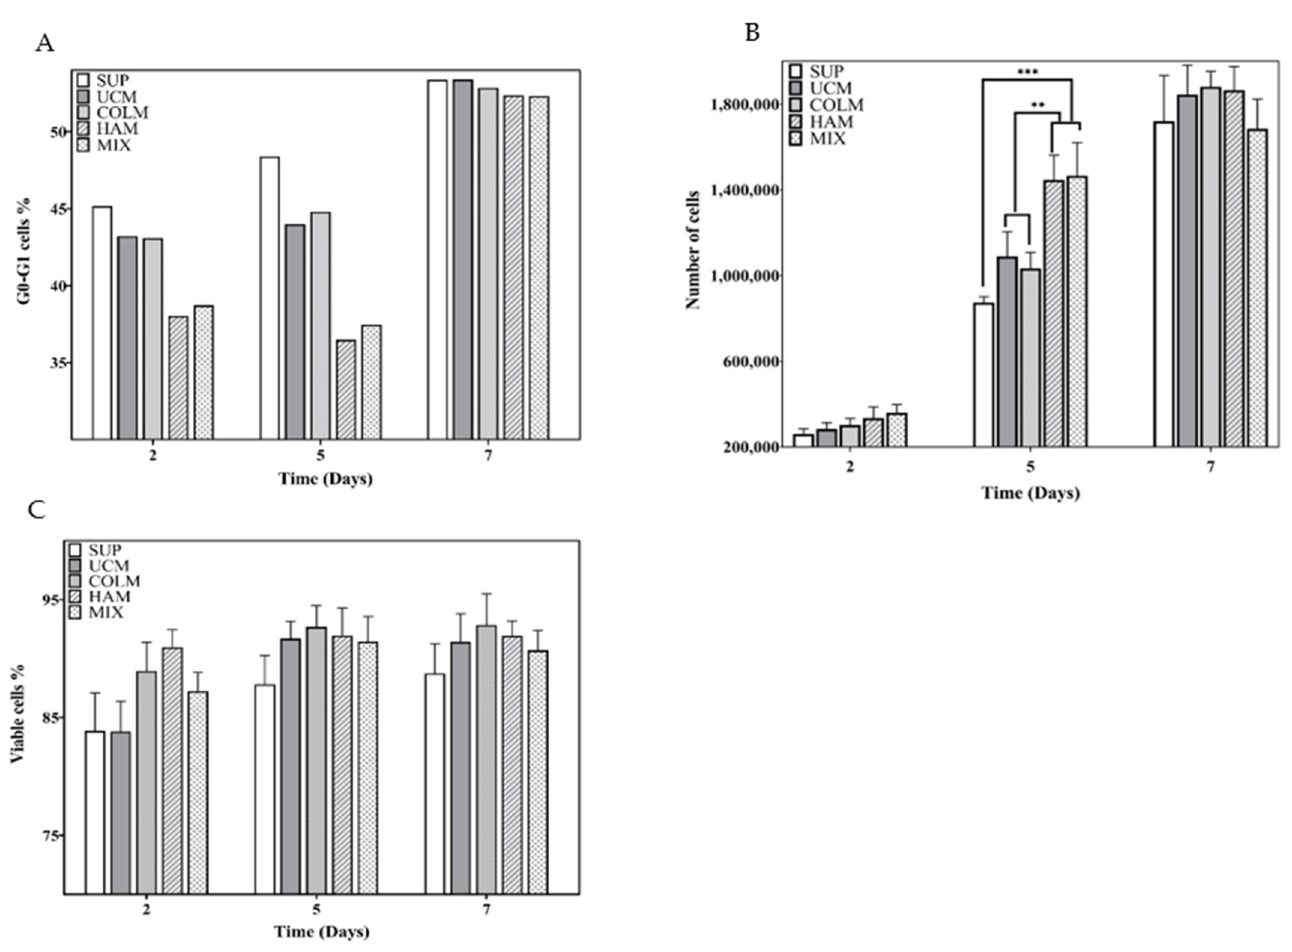
Figure 4. ( A ) Fraction of cells in G 0 –G 1 phases; ( B ) cell number in the different culture environments; ( C ) percentage of cell viability. The level of statistical significance is shown as: (**) p -value ≤ 0.01; (***) p -value ≤